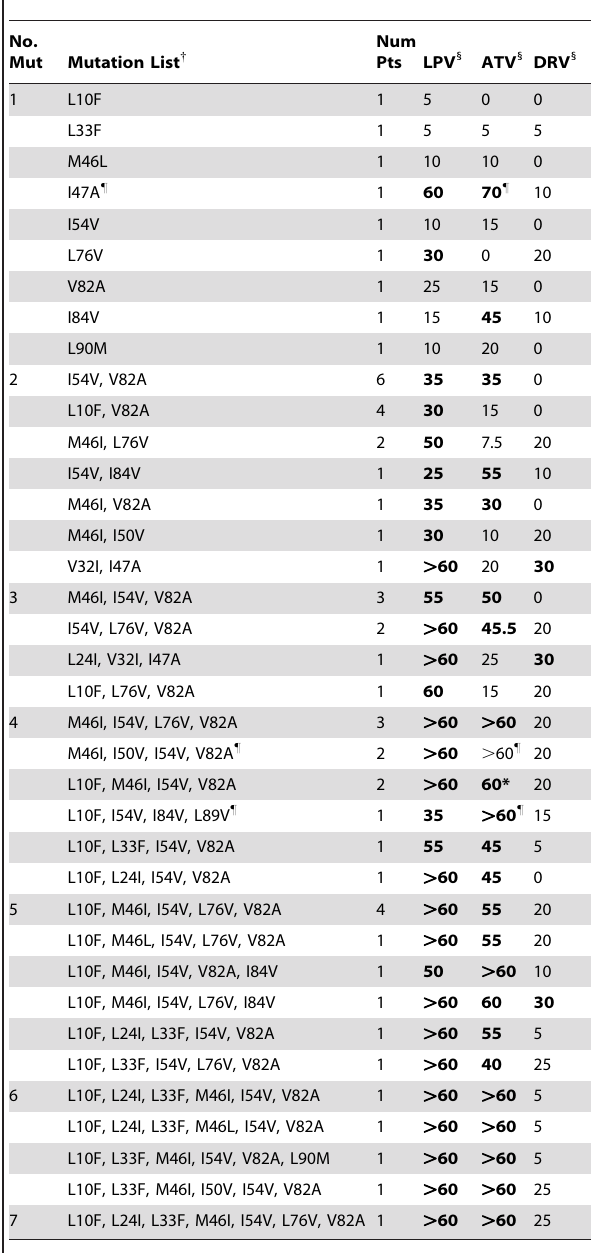
Table 5. Protease Inhibitor (PI)-Resistance Mutation Patterns in Viruses From Patients Receiving Lopinavir/r and their Predicted Effect on PI Cross Resistance*.